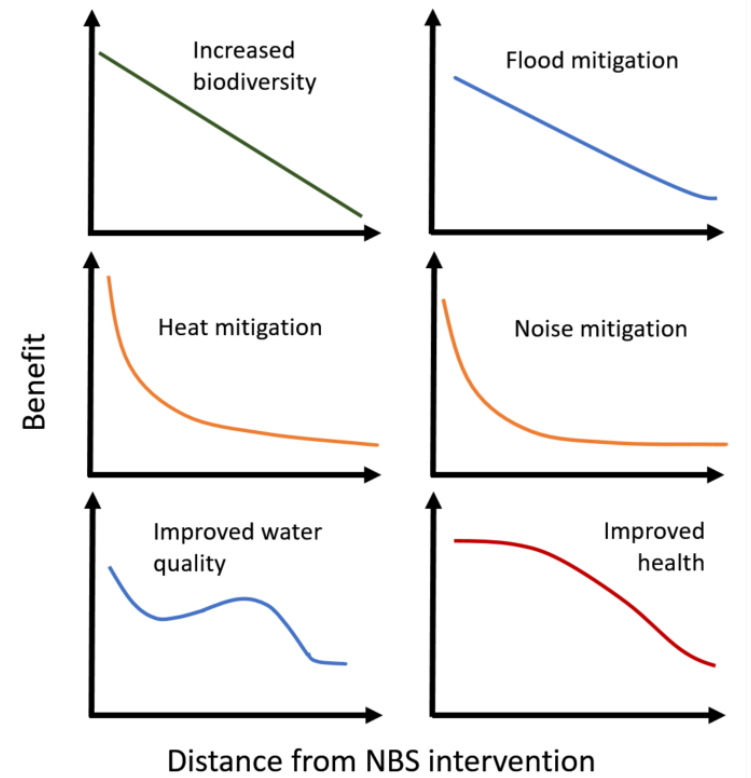
Figure 1. Distance-decay functions for the influence of benefit with distance from the NBS. Modified from [7].